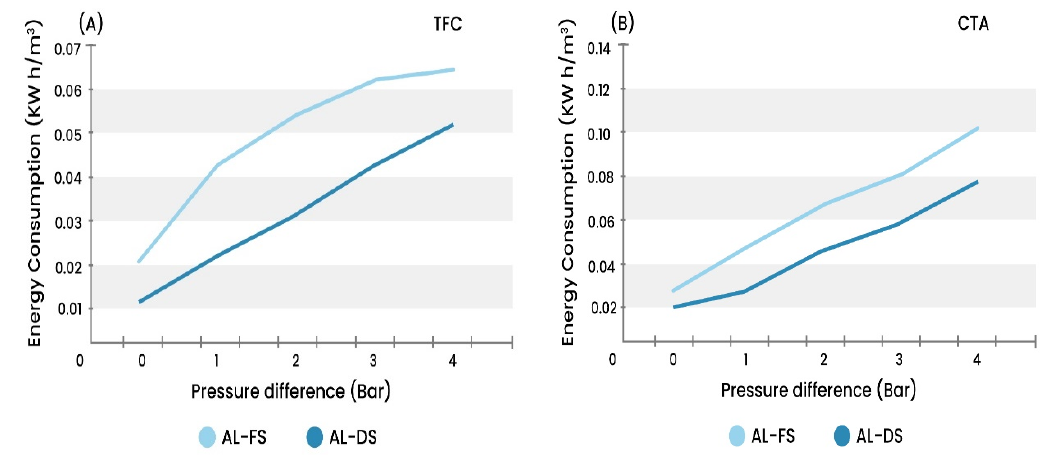
Figure 11. Energy consumption at different applied pressures, ( A ) using TFC membrane and ( B ) using CTA membrane.